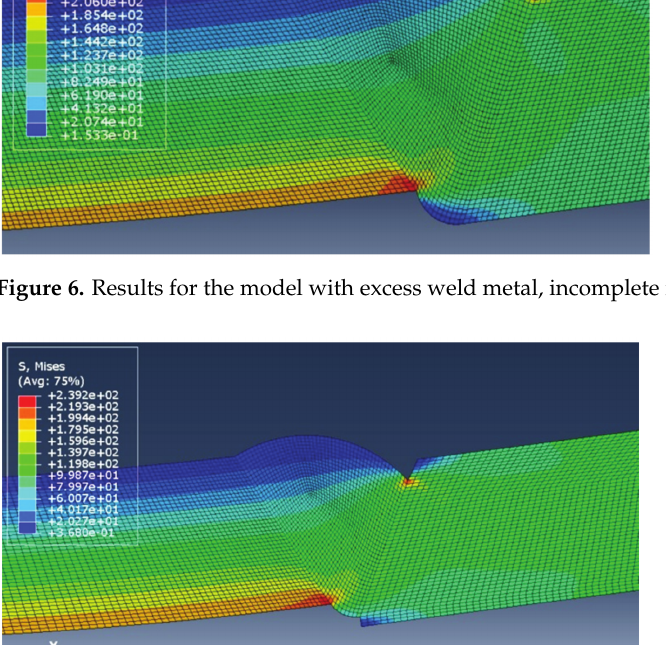
Figure 7. Results for weld metal sagging and incomplete root